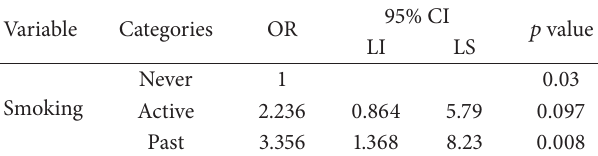
Table 10: Multivariate analysis: PD-L1 expression in tumor cells.